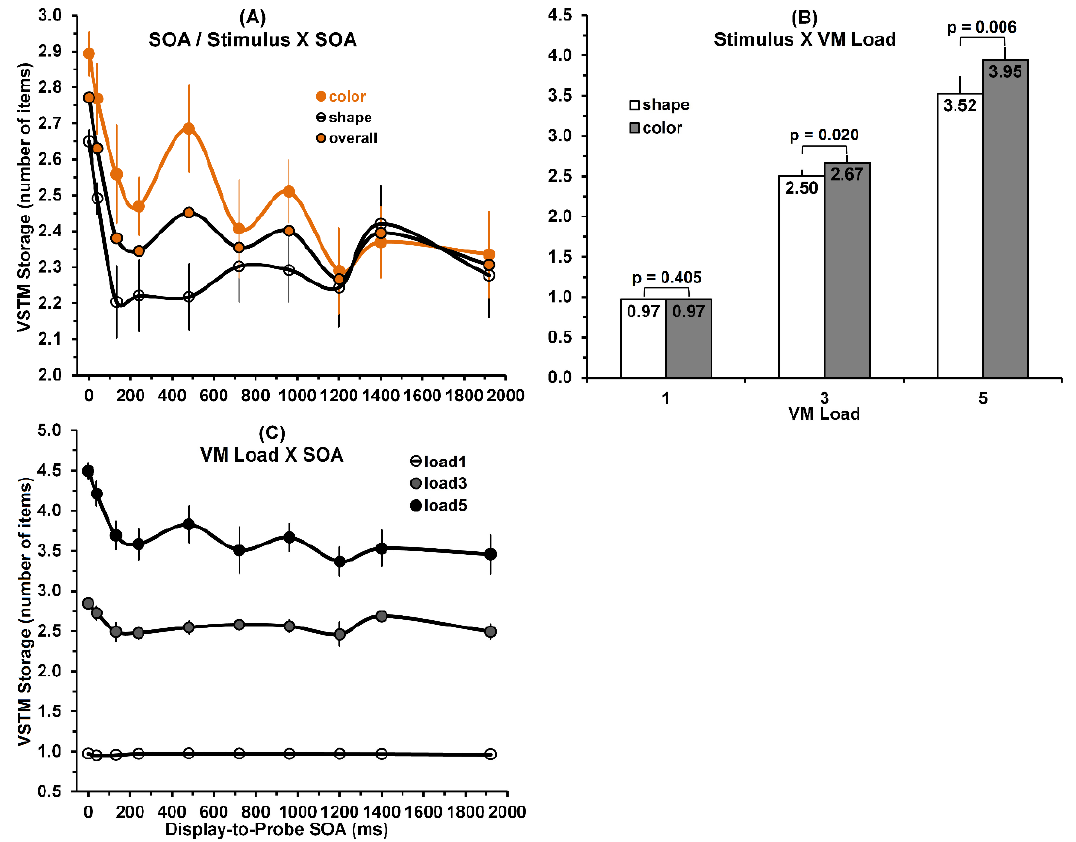
Figure 3. VSTM storage as a function of display – to – probe SOA. (Panel A ): Orange, oopen, and orange – filled circles correspond respectively to color, shape, and overall storage values. The data illustrate the significant main effects of stimulus and the significant stimulus × SOA interaction. (Panel B ): The significant stimulus × VSTM load interaction. (Panel C ): The significant VSTM load × SOA interaction.